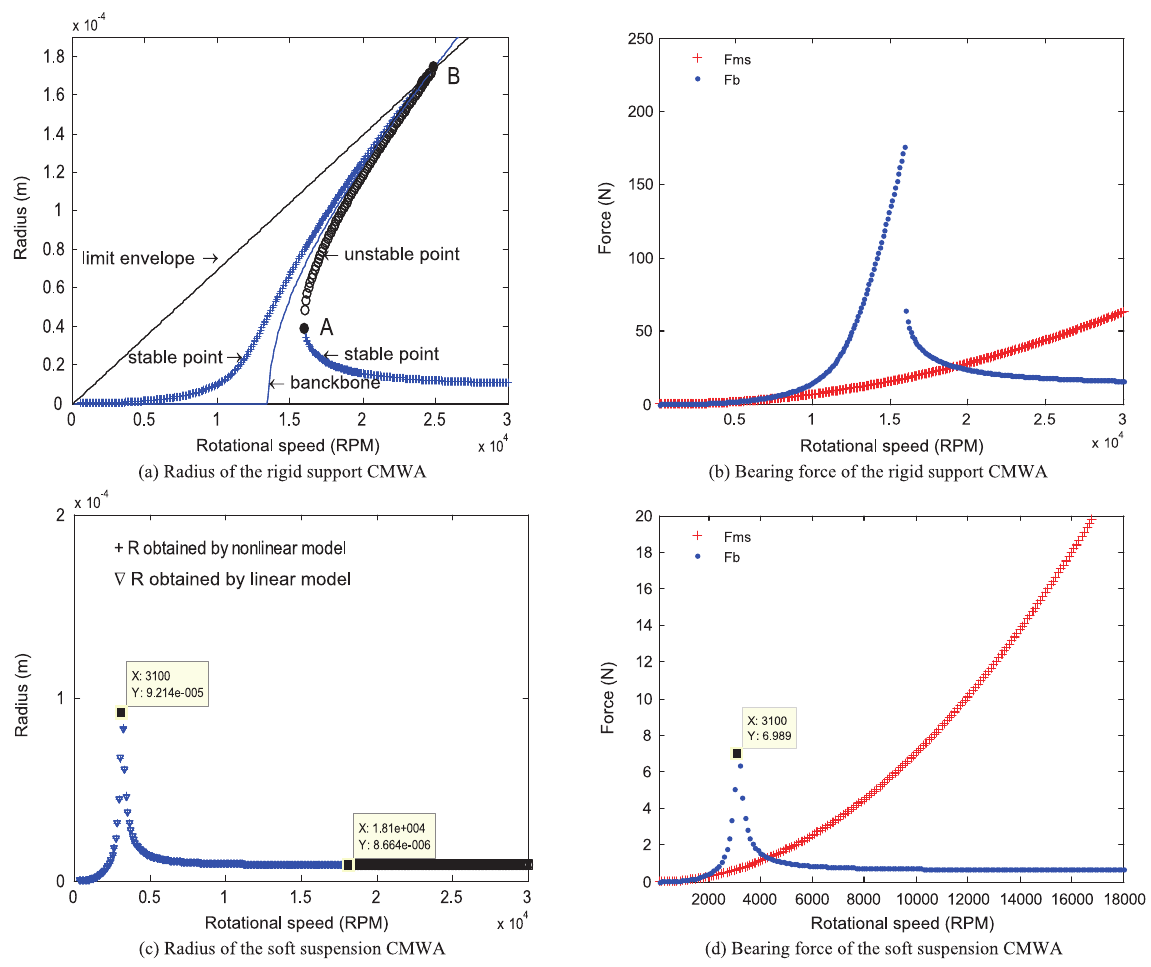
Fig. 7. Imbalance response before and after in